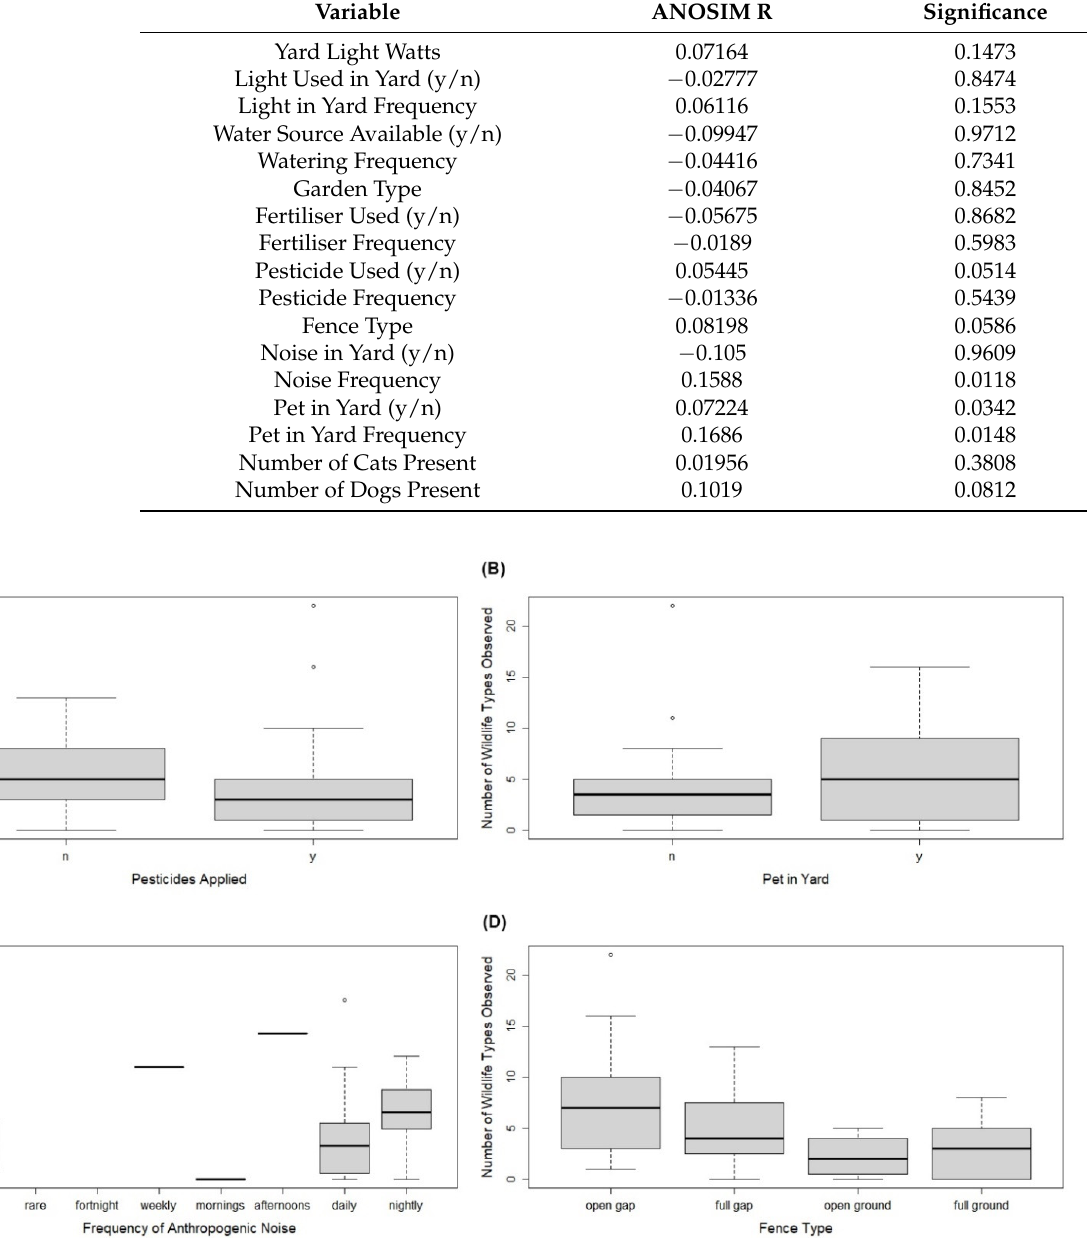
Table 2. Analyses of similarity results testing the number of types of wildlife observed at a property against each categorical variable independently.